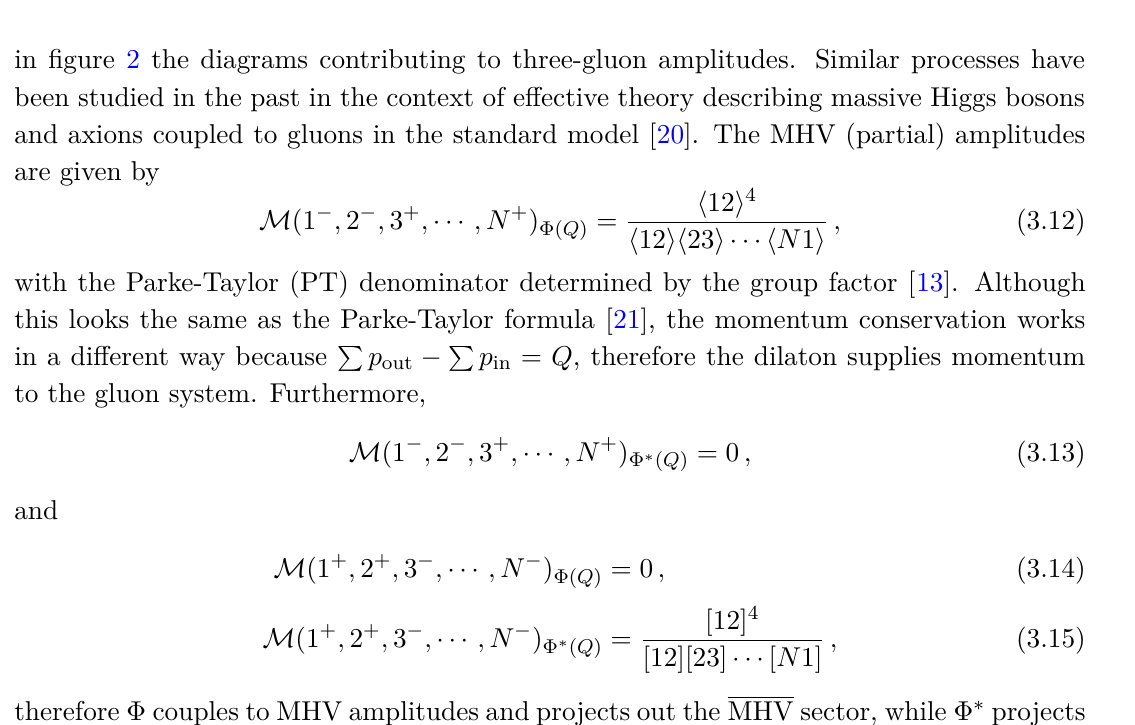
Figure 2 . Feynman diagrams for three gluons coupled to the dilaton